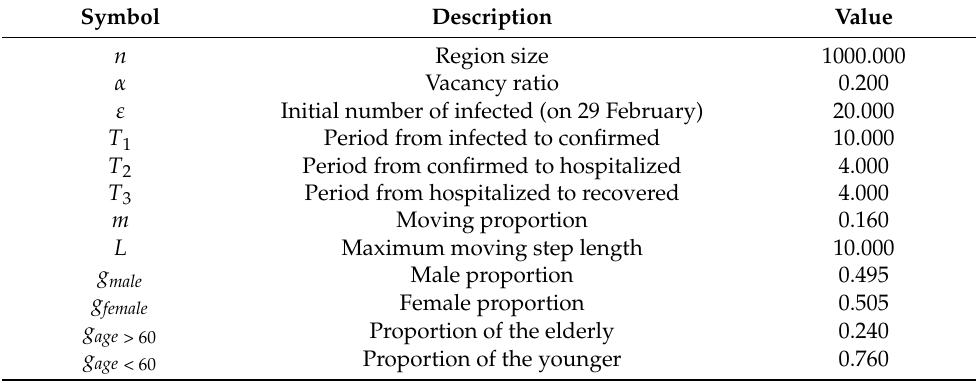
Table A2. The parameters set for Iowa.